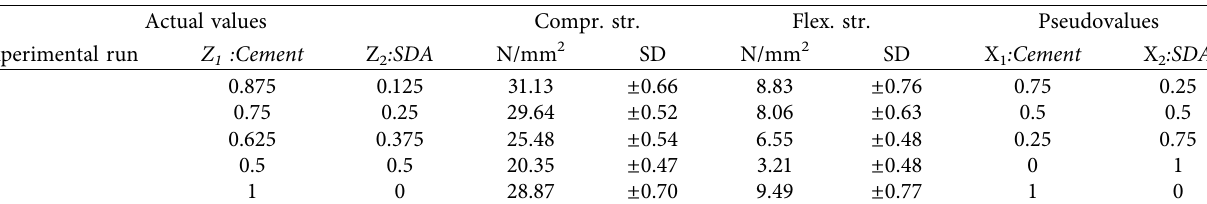
Figure 7: Effects of SDA interaction with cement on the mechanical strength response. Table 8: Laboratory